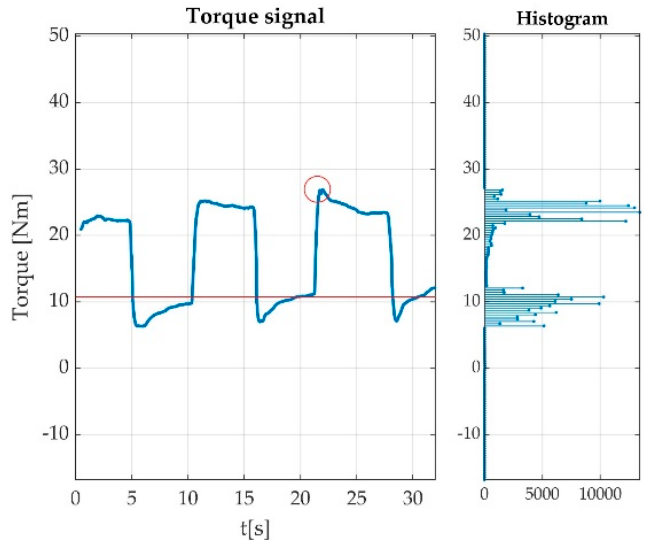
Figure 11. An example of erroneous detection; the maximum of histogram appears at the flexion level, rather than at the offset level; the red circle represents the maximum of histogram during plantar flexion, which does not represent the offset level, instead represented by the red line.